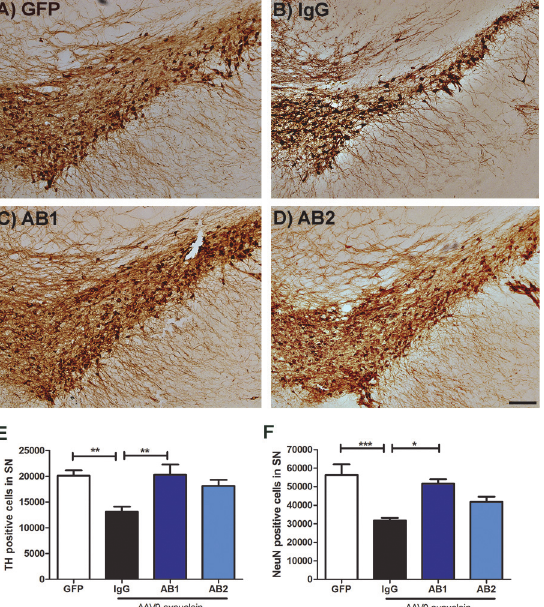
Fig 4. Rescue of TH+ and NeuN+ cells in the ipsilateral SN with intraperitoneal administration of anti- α -Syn antibodies. Immunohistochemical staining of the SN region with an anti-TH antibody (A) AAV-GFP, (B) AAV- α -Syn + IgG, (C) AAV- α -Syn + AB1, (D) AAV- α -Syn + AB2. (E) Graph of unbiased stereological estimation of TH+ cells in the SN of treated animals. AB1 treated animals showed similar levels of TH+ cells compared to the GFP control and significantly higher number of TH+ cells compared to the IgG treated group. Data are shown as mean ± SEM (n = 13 AAV-GFP control and n = 7 for treatment groups). (F) Graph of NeuN + cells of the SN. Stereologic analysis shows a significant rescue of NeuN+ cells in SN sections with AB1 compared with IgG treated animals (n = 9 AAV-GFP control and n = 7 for treatment groups). * P < 0.05, ** P < 0.01, *** P < 0.001. Scale bar = 100 μ